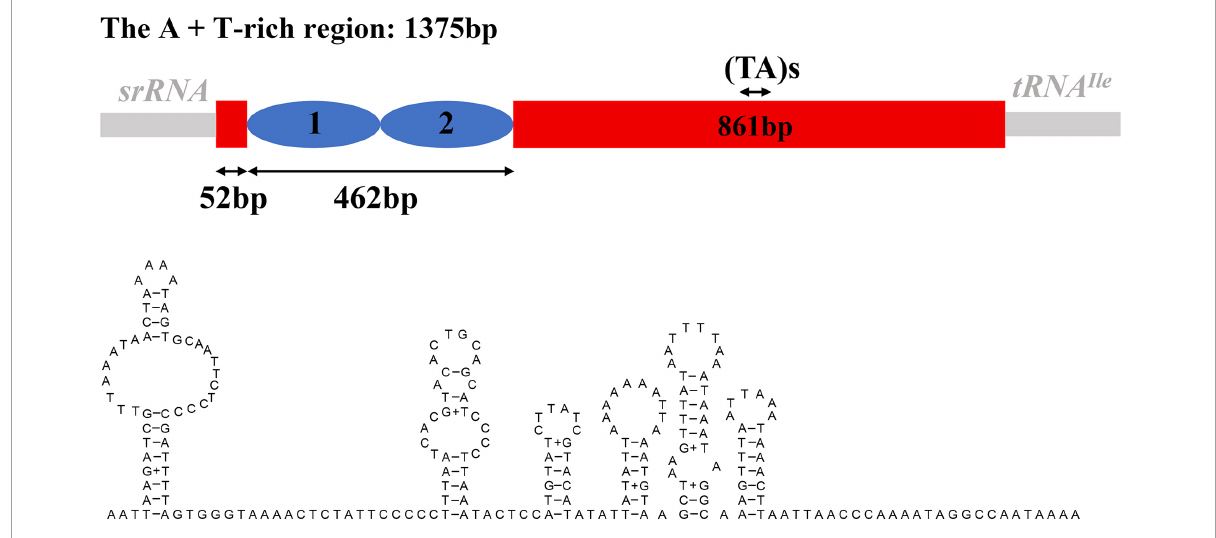
FIGURE5 The structure of the A + T-rich region and possible secondary structures within the specific position of S. jisigouense .